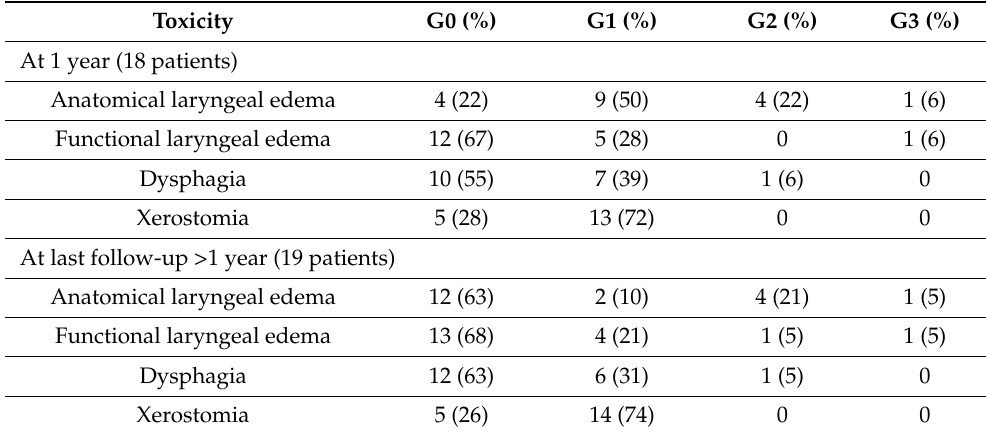
Table 3. Toxicity profile at one year from the end of